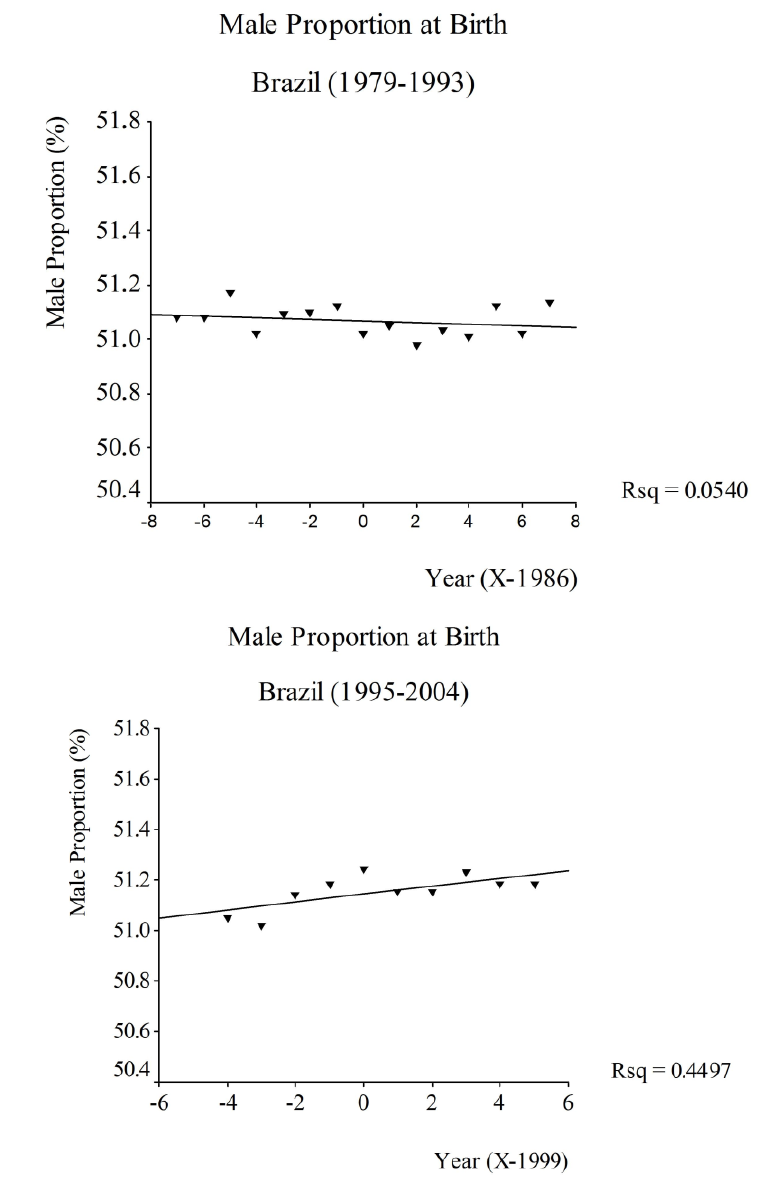
Figure 2. ( A) Time trend of male proportion at birth, Brazil, 1979-1993; (B) Time trend of male proportion at birth, Brazil,